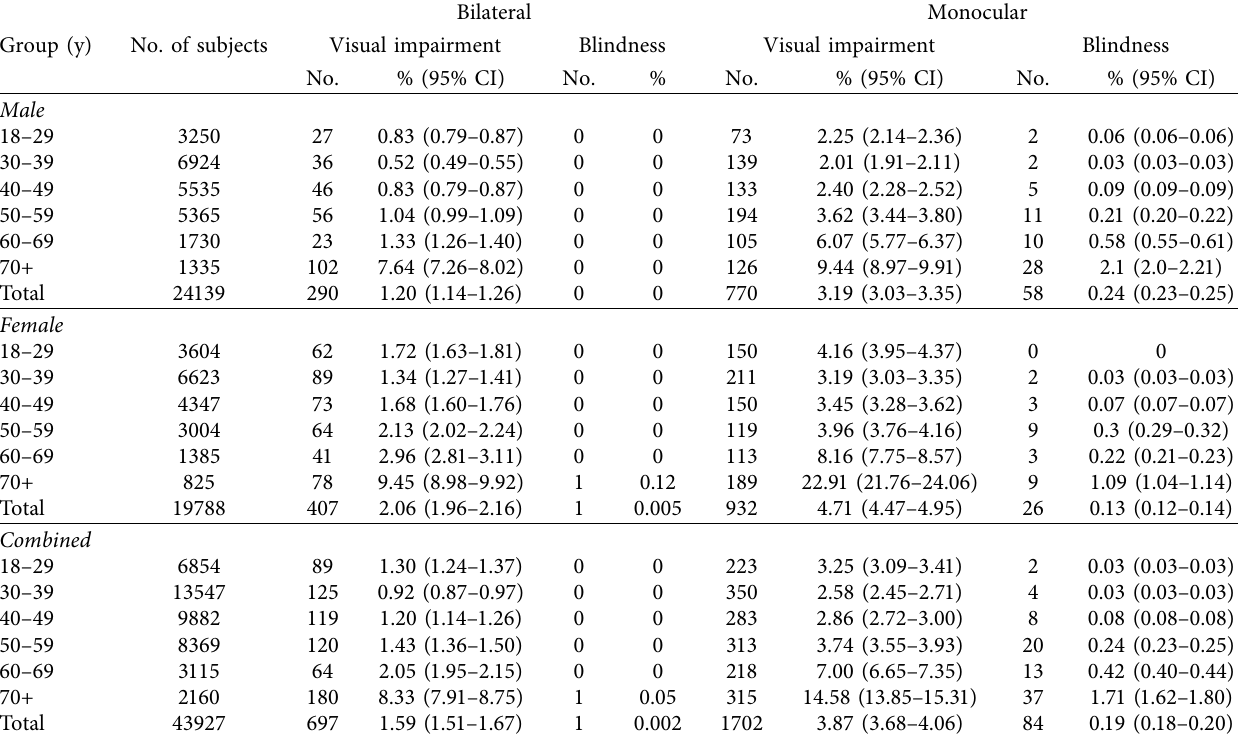
Table 1: Prevalence of presenting visual impairment and presenting blindness (World Health Organization defnition) stratifed by age and gender. Group